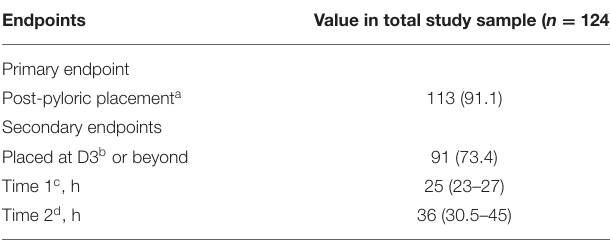
TABLE 2 | Primary and secondary endpoints. TABLE 3 | Adverse